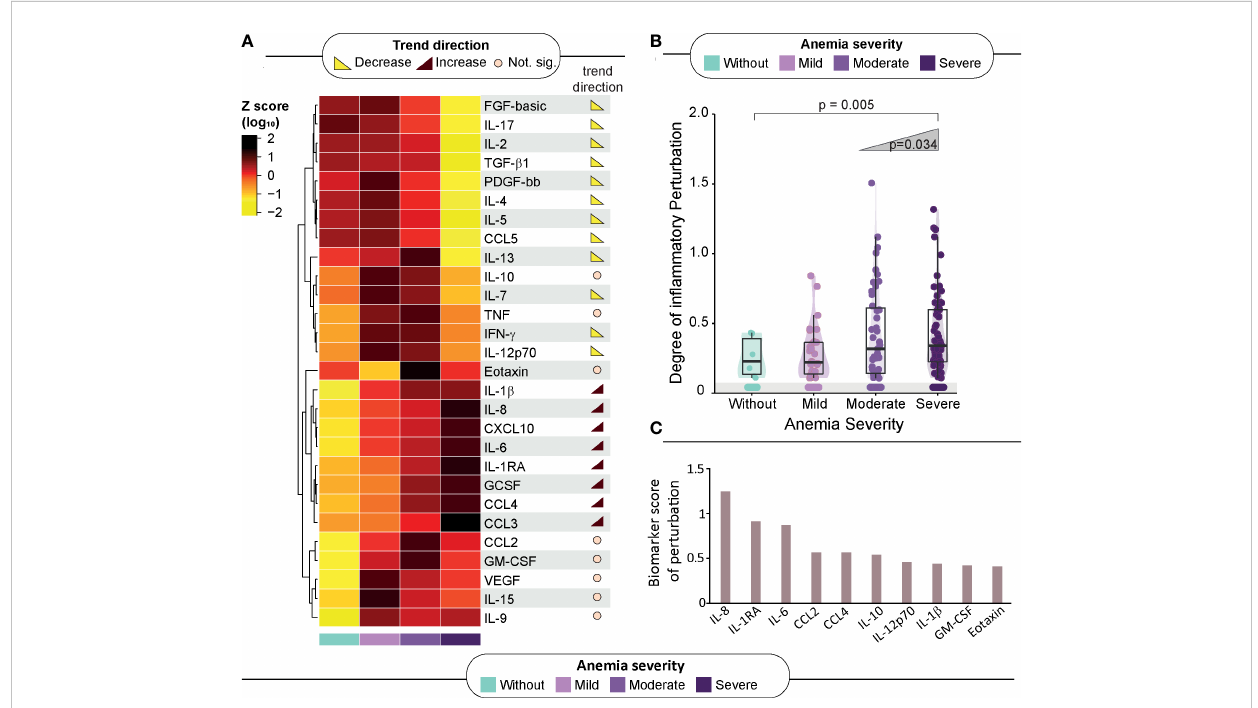
FIGURE 2 Association of anemia severity with in fl ammatory pro fi le. (A) Left panel: A heatmap was designed to depict the overall pattern of in fl ammatory markers. A one-way hierarchical cluster analysis (Ward ’ s method) was performed. Dendrograms represent Euclidean distance. Right panel: Several analyses were performed to identify trends of increasing or decreasing of biomarker levels across anemia severity. Signi fi cant differences (p < 0.05) are highlighted in red-brown trend symbol when the trend is increasing and in yellow when the trend is decreasing. For those of no signi fi cance, there is a beige circle. (B) Scatter plots of the degree of in fl ammatory perturbation (DIP) value grouped according to anemia severity. Lines in the scatter plots represent median values and data were compared using the Mann – Whitney U test. The Cochran – Armitage test for trend was used to assess the tendency of increased levels or frequencies among groups. (C) We identi fi ed the Top 10 biomarker scores contributing to overall perturbation. The score was obtained using DIP approach. Mild anemia was de fi ned as Hb value >10 g/dL and <13 g/dL for men; and >10 and <12 g/ dL for women, whereas moderate anemia was de fi ned as Hb>8 g/dL and <=10 g/dL for both sexes. Severe anemia was de fi ned as Hb<8g/dL for both